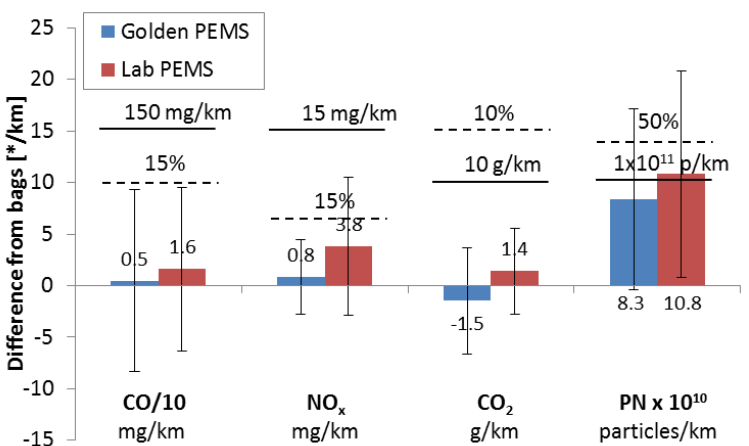
Figure 2. Mean differences of PEMS (Golden PEMS: one instrument, Lab PEMS: five instruments) from bag (tunnel) results for the World Harmonized Light-duty Test Cycle (WLTC). Dashed lines show relative permissible tolerances. Solid lines show absolute permissible tolerances [16,17]. Error bars show one standard deviation.